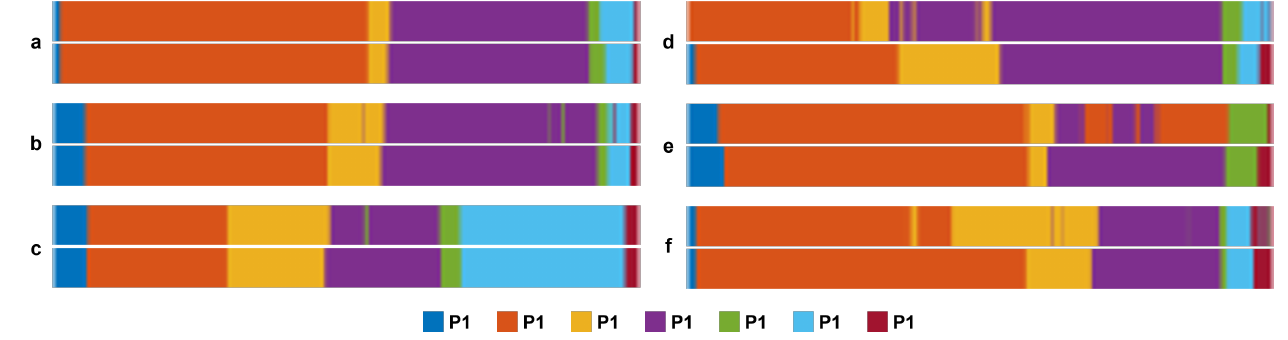
Figure 6. Color-coded visualization for phase recognition results of the top-3 ( a , d , c ) and bottom-3 ( d , e , f ) procedures. The ground truth is at the top, and the prediction is at the